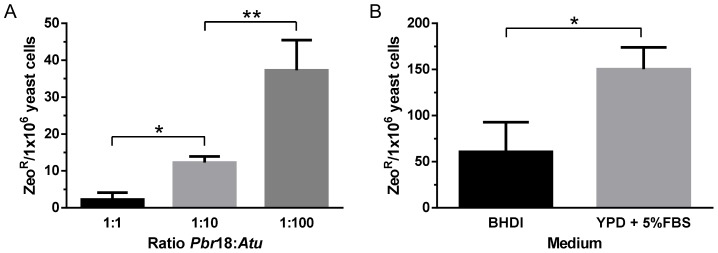
ATMT of P. brasiliensis to certify the Zeocin/ZeoR positive selection system and the terminal GP43 gene transcription region.(A). Four independent transformation experiments were performed by co-cultivating 1×106 viable Pb18 yeast cells with A. tumefaciens at different ratios. A. tumefaciens carried the “PrmCBP1::Shble::TtrGP43” cassette to express the ZeoR selection marker (*, P = 0.0002; **, P = 0.001). (B). Three independent transformation experiments were performed by co-cultivating 1×106 viable Pb18 yeast cells with A. tumefaciens at a ratio of 1∶100 and recovering the yeast cells using two different selective media (*, P = 0.02).